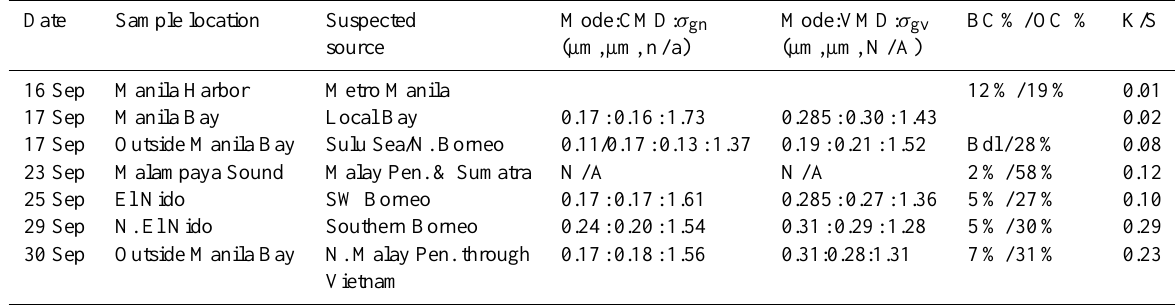
Table 1. Particle size and chemistry characteristics for aerosol environments at the cruises’s key sampling